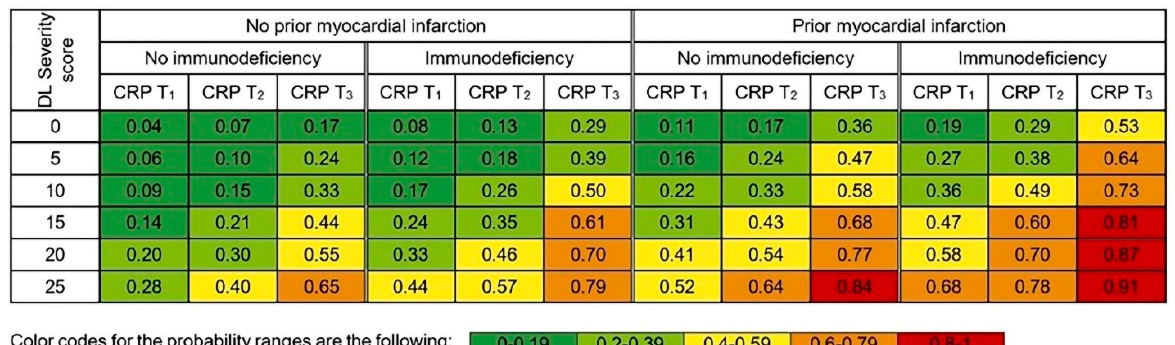
Figure 2. Deep learning–based probability of clinical deterioration for given severity score values as stratified by history of